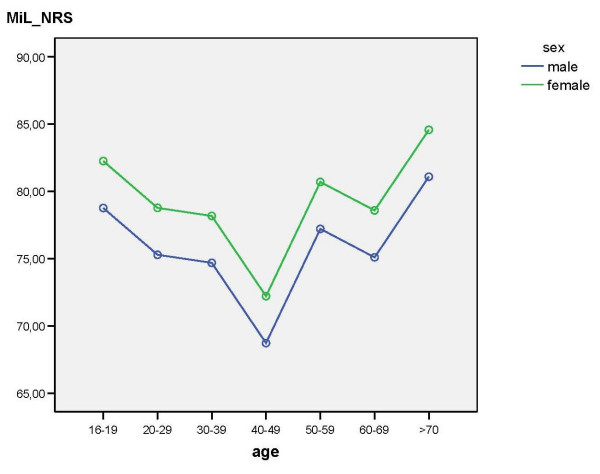
Results of the multifactorial analysis with the effects of age and gender on MiL_NRS.